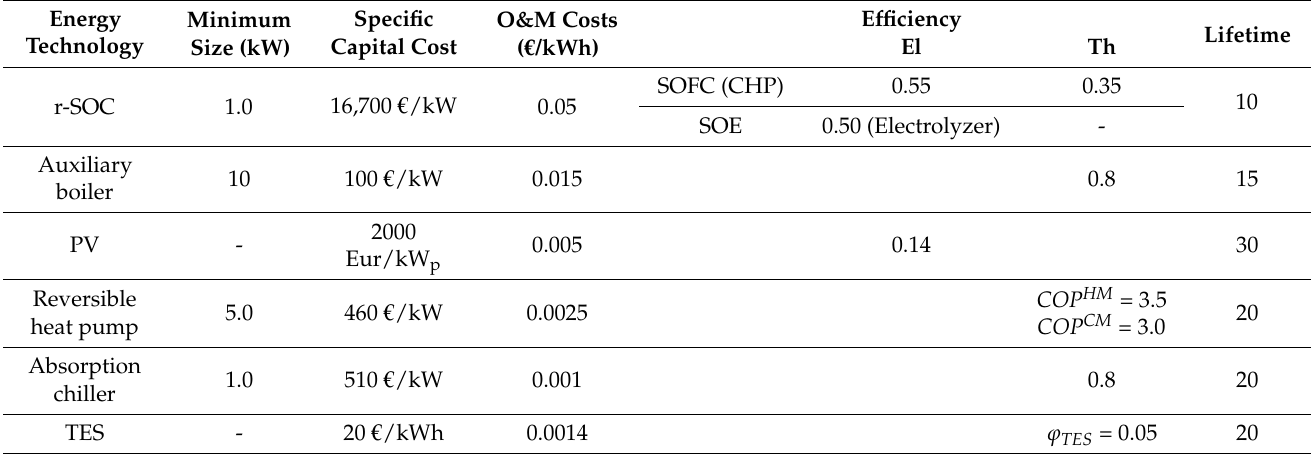
Table 1. Techno–economic characteristics of energy technologies in the MES superstructure [26–28].